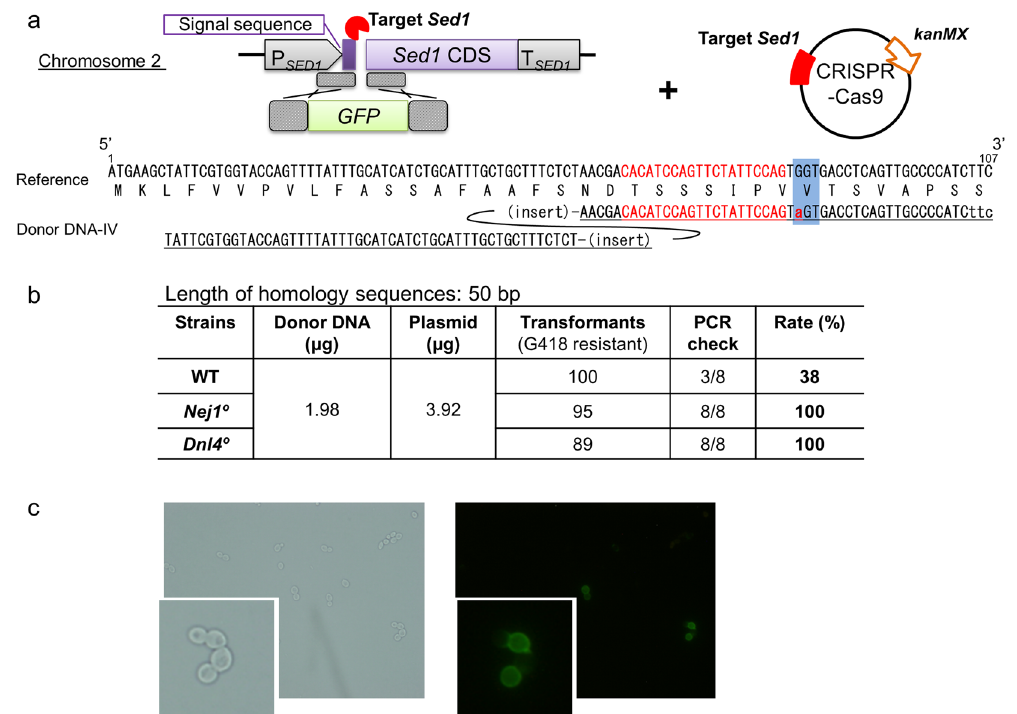
Figure 6. Direct fusion of GFP-coding sequence into a chromosomal locus. ( a ) Schematic showing integration of the GFP-coding fragment into the Sed1 CDS. The CRISPR-Cas9 plasmid targeted (indicated by lightning bolts) the end of the signal peptide-coding region of Sed1 . Dashed boxes indicate homologous regions. Left arm is homologous to the end of to the signal peptide-coding sequence (bp 8 to 57 with respect to the start of the Sed1 coding sequence). Right arm is homologous to Sed1 sequence (bp 58 to 107 with respect to the start of the Sed1 coding sequence) with substitution at bp 84 (G to A; indicated by lower-case letter in red font) to eliminate a PAM. ( b ) The successful integration rate was calculated as PCR check * 100. ( c ) Representative microscopic image of positive transformants ( Nej1° /GFP_Sed1) under bright-field (left) and fluorescent (right) illumination. Insets show 3-fold magnified images.